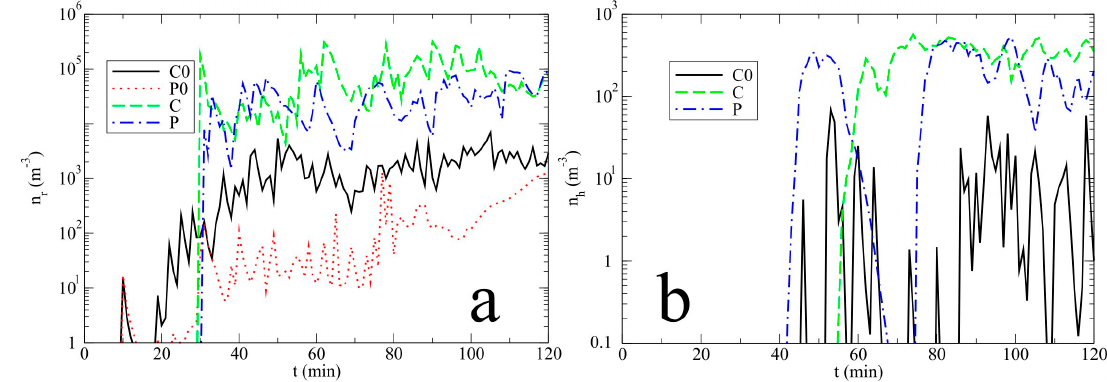
Figure 14. As in Figure 3, but for the maximum number concentration (m − 3 ) of ( a ) rain and ( b ) hail.